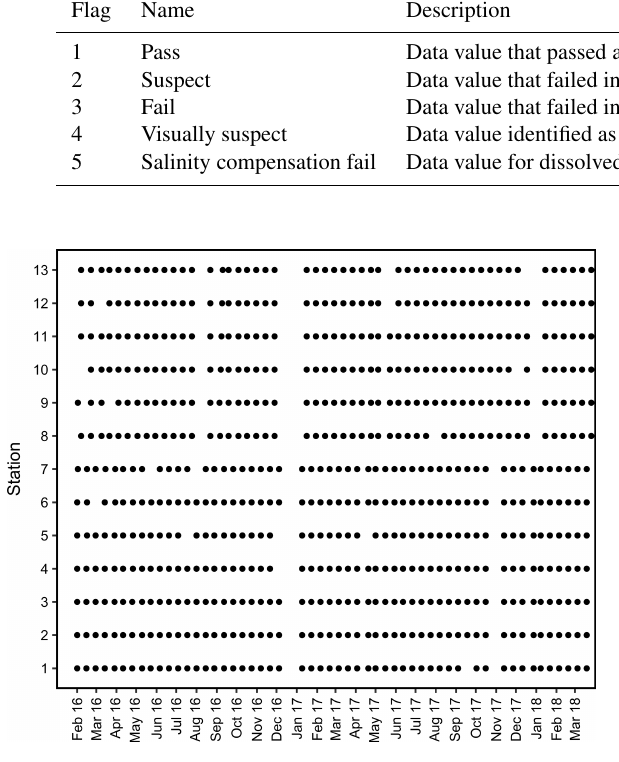
Figure 3. Data availability of dissolved inorganic nutrient concen- trations. Each dot represents a measurement for total oxidized ni- trogen, nitrite, ammonia, phosphate and silicate.